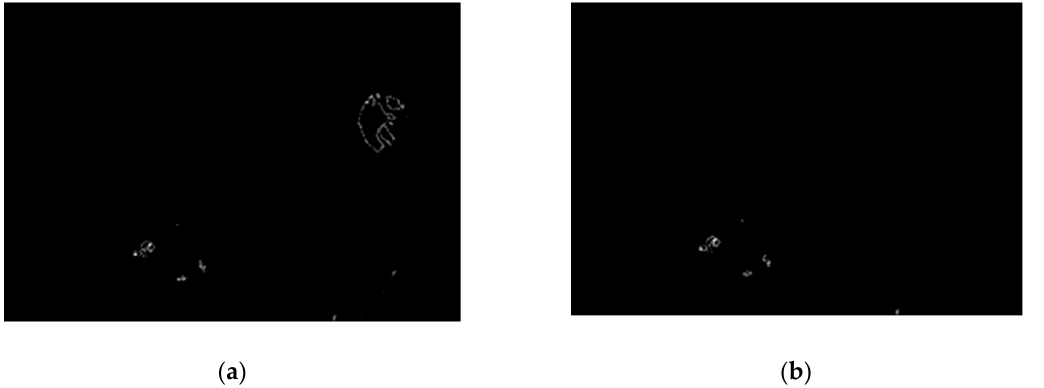
Figure 17. Image after ( a ) calculating its variance and ( b ) after optic disk removal.